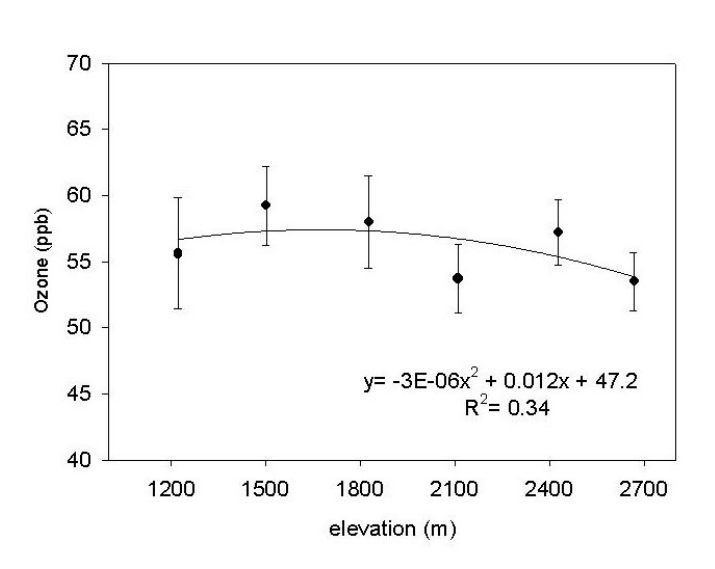
FIGURE 4. Concentrations of ozone (ppb) determined with passive samplers exposed during 2-week long periods during summer 2000.